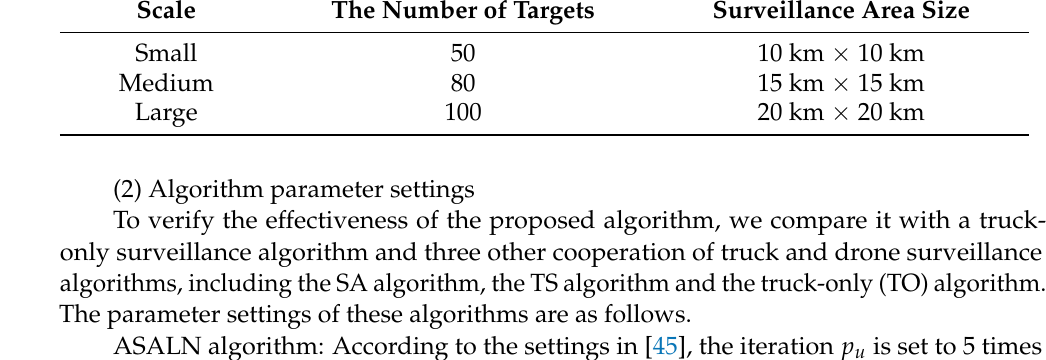
Table 2. The setting of synthetic cases